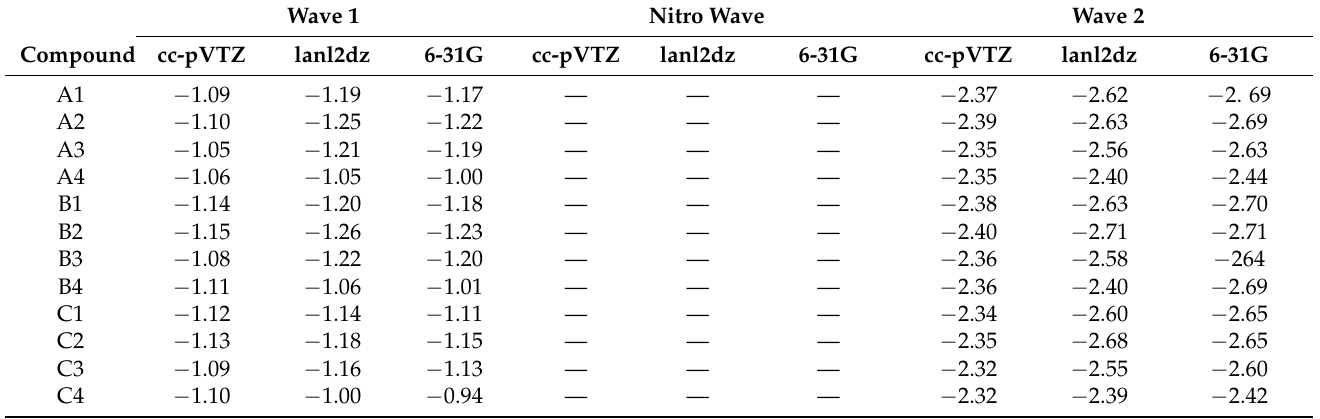
Table 3. The adjusted electrochemical wave 1, nitro wave, and wave 2 reaction potentials ( ε (cid:48) cell , , in Volts) with the Fc/Fc + reduction potential set to zero calculated using B3LYP/cc-pVTZ and